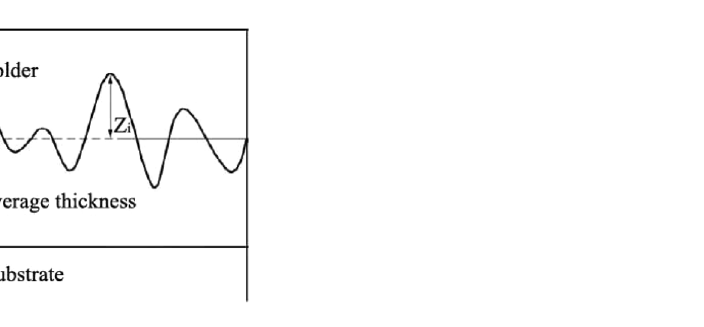
Figure 2. Parameters of the soldering process and thermal cycling: ( a ) processing parameters for the solder joints, ( b ) thermal cycling curve.